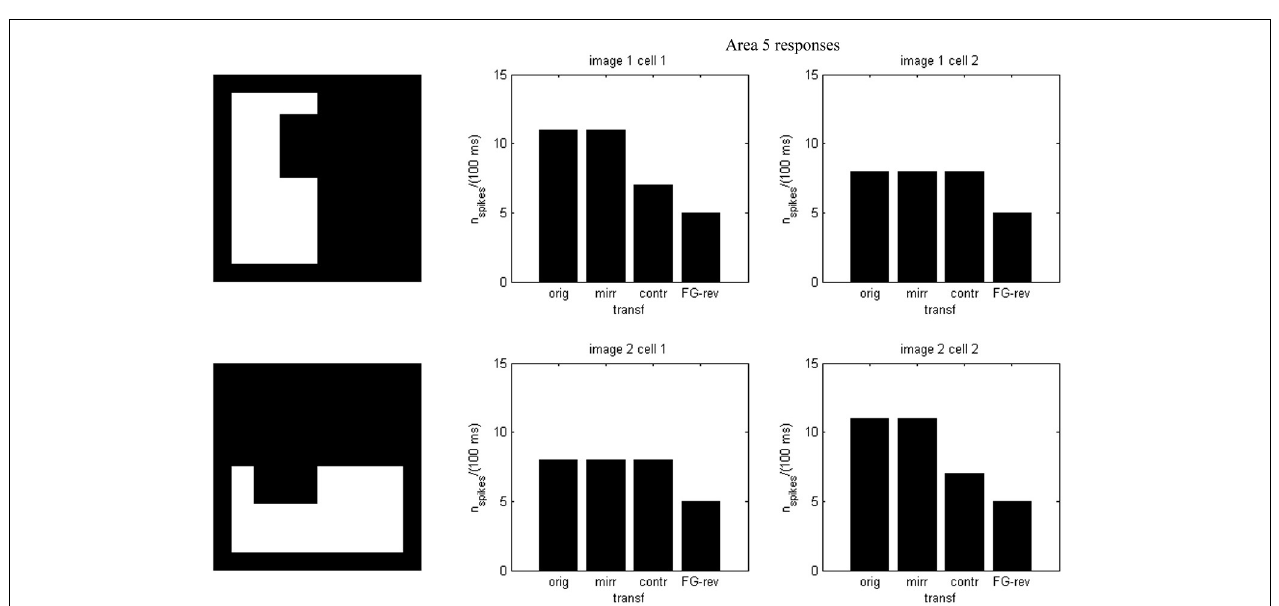
FIGURE 9 | Spike counts for the images of Figure 8. Cell 1 and cell 2 counts are interchanged.